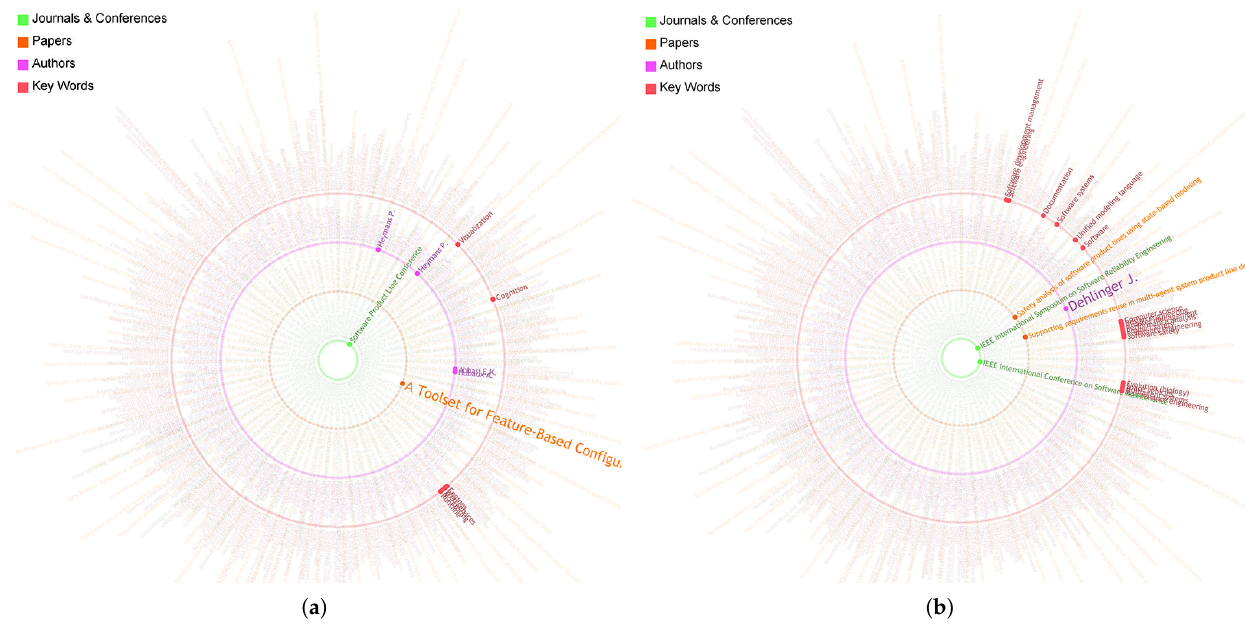
Figure 7. Overview step while an entity has been selected. ( a ) A paper has been selected; ( b ) An author has been selected.